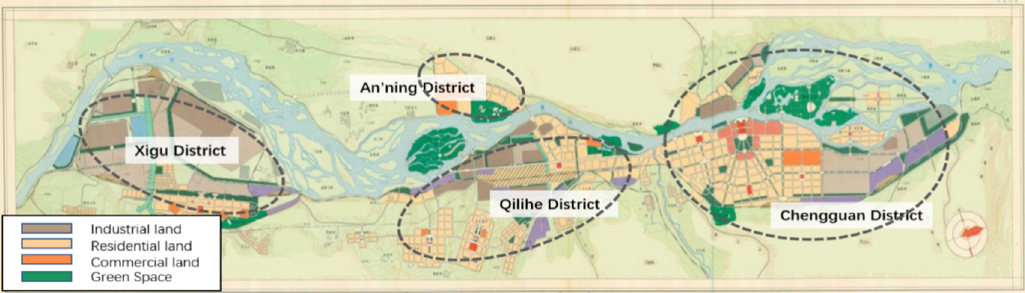
Figure 2. Lanzhou City Master Planning (1954–1972). Source: Lanzhou Nature Resource Bureau.